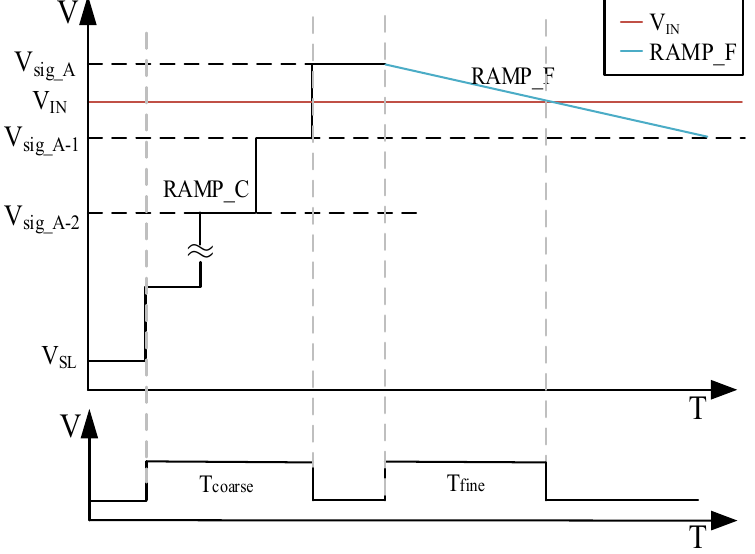
Figure 2. Schematic diagram of normal conversion.